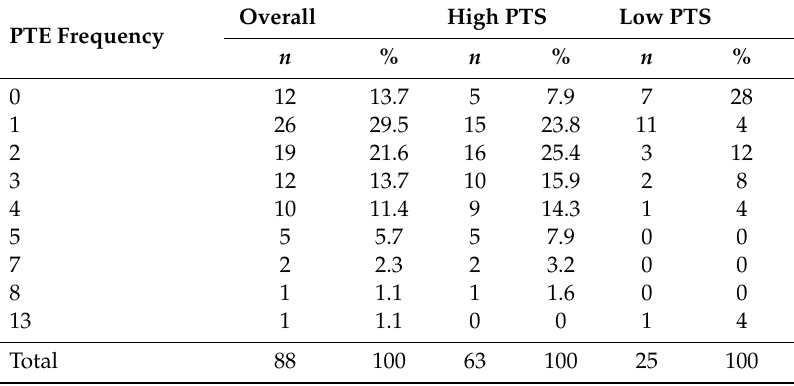
Table 2. Frequency of total number of PTEs for all participants, participants above the PCL cuto ff of 30 (High PTS), and participants below the PCL cuto ff of 30 (Low PTS).